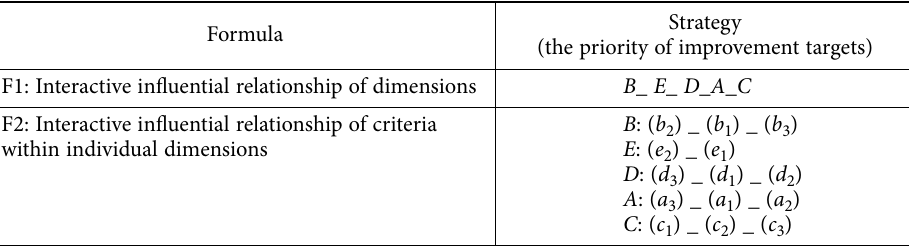
Table 8. AI-enabled auditing implementation improvement plan for CPA firms based on DEMATEL method Formula